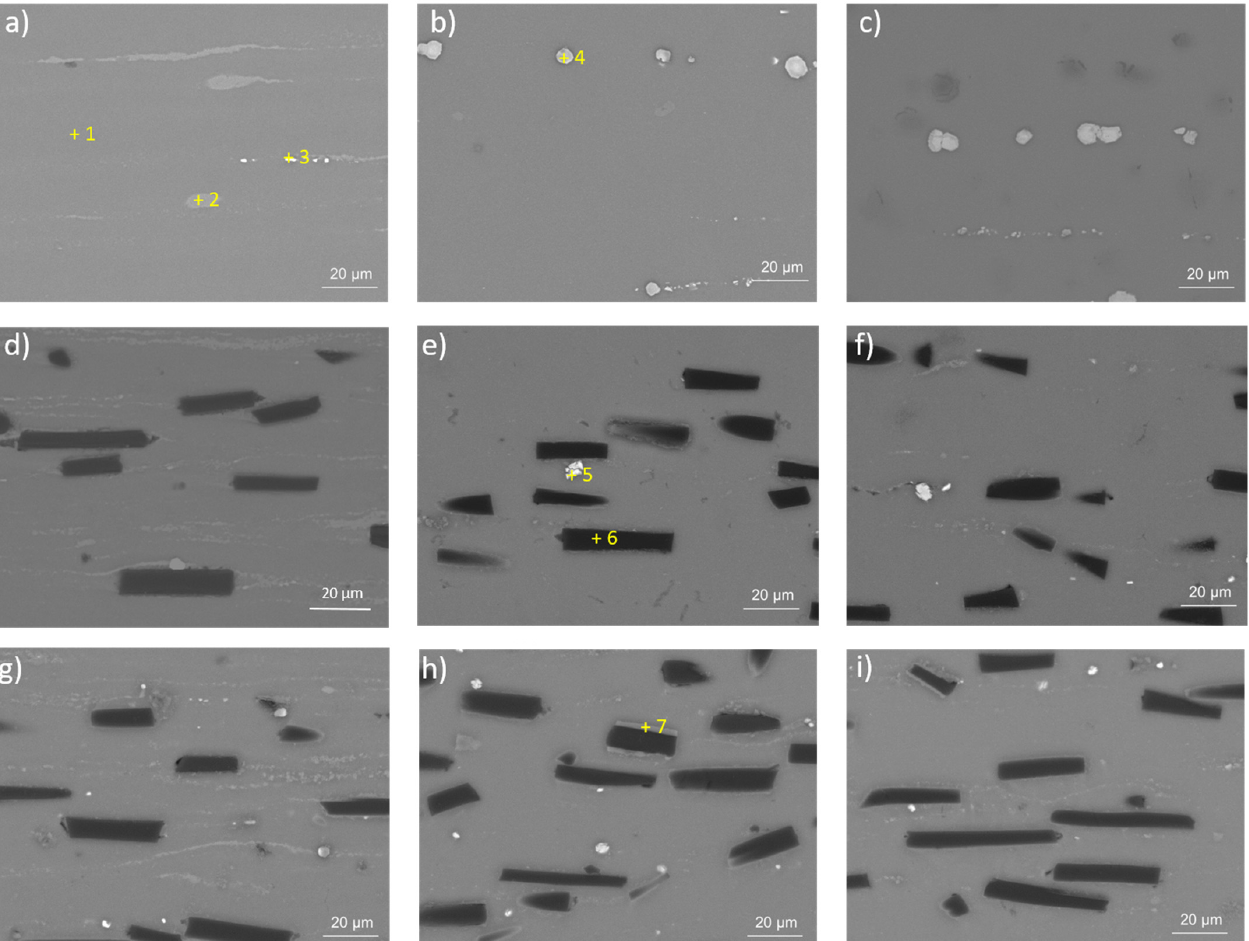
Figure 2. BSE micrographs of the samples, taken with the extrusion direction horizontal across the page: ( a – c ) AZ91, as extruded, T4, T6; ( d – f ) AZ91/C100/5f as extruded, T4, T6; ( g – i ) AZ91/C500/5f as extruded, T4, T6. The composition of the numbered positions is provided in Table 3. Composition from EDX analysis of positions marked on Figure 2.